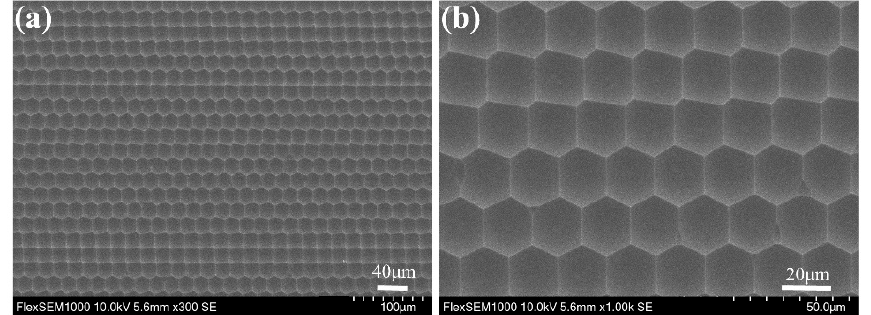
Figure 3. ( a ) Top-view SEM image of the quasi-periodic MLA and ( b ) a magnified SEM image of the quasi-periodic MLA. Table 2. The molding conditions and process parameters used in this study.